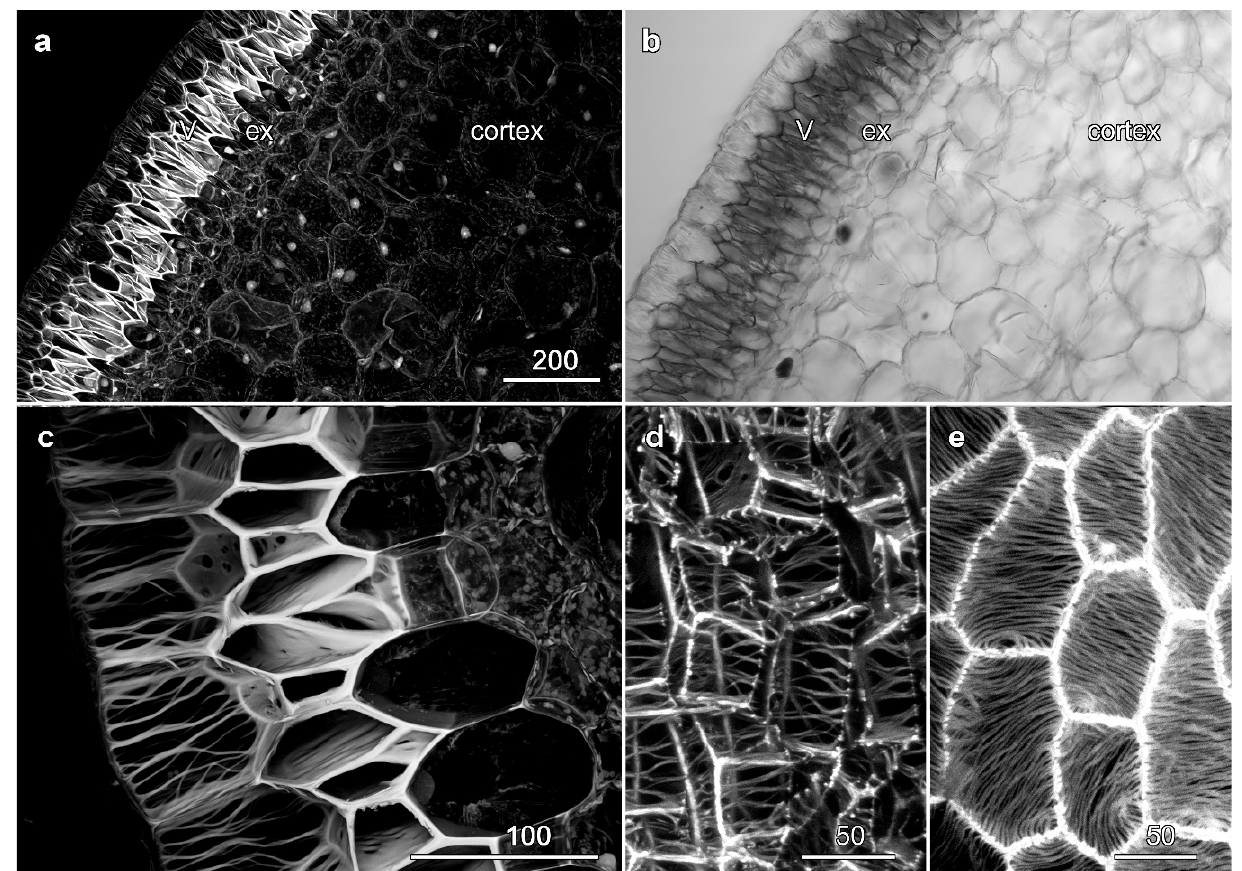
Figure 5. Velamen organization in Phalaenopsis sp. roots. Images ( a , c – e ) are maximum projections of confocal optical series collected of basic fuchsin labelling. ( a , b ) Cross section showing lignified velamen (V) but unlignified exodermis (ex) walls, along with a concurrent transmitted light image. ( c ) Higher resolution image of cell wall thickenings in the velamen. ( d ) Longitudinal sections through the outer face of the velamen showed either irregular cell wall ridges ( d ) or more commonly, narrowly spaced, broad swirls of secondary walls ( e ). See also Supplementary Movies S7 and S8. Bar in ( a ) = 200 µm for ( a , b ); bar in ( c ) =100 µm.; bars in ( d , e ) = 50 µm.